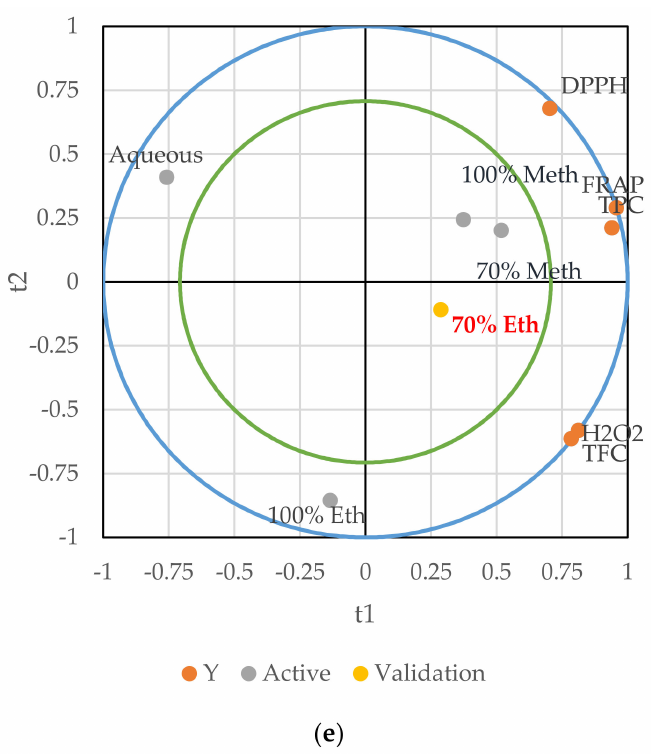
Figure 1. Partial Least Squares regression analysis (PLS) of the validation of the different extracts in the extraction of the phytochemical compounds and antioxidant activities of the aerial wasted parts of onion ( a ), white radish ( b ), red radish ( c ), beet ( d ), and carrot ( e ). Correlation on access t1 and